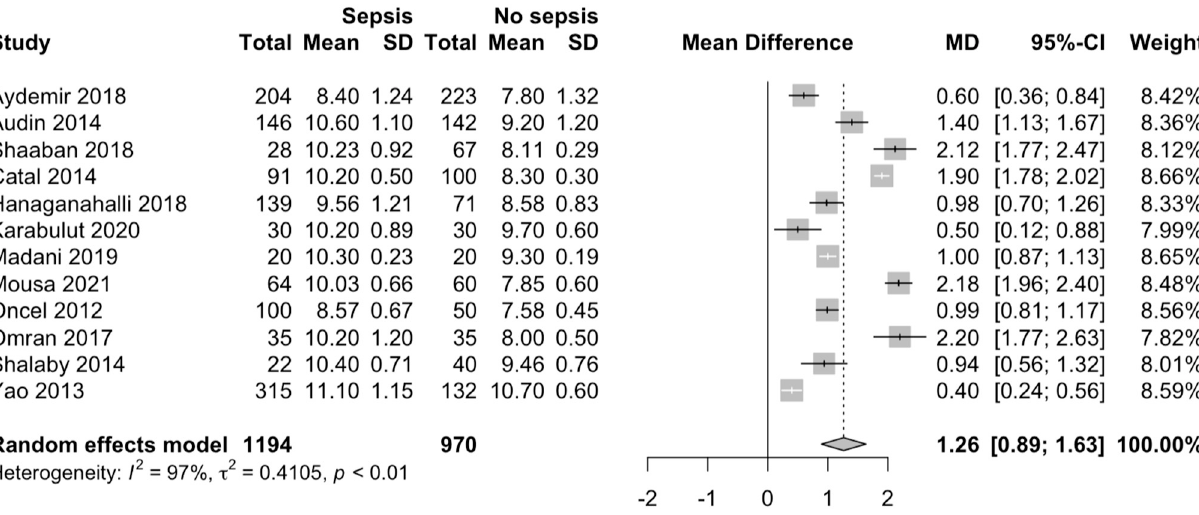
Table 2. Diagnosis accuracy between studies.